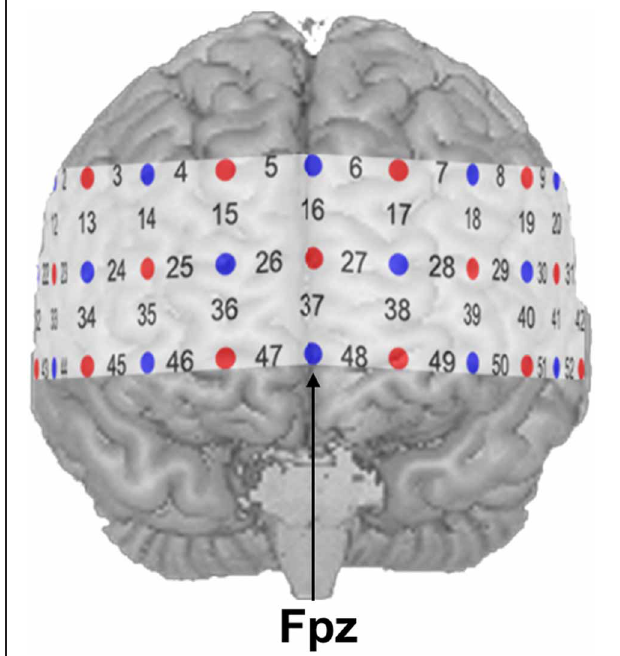
FIGURE 1 | NIRS probe set with 52 channels. Emitters and detectors are represented by red and blue circles, respectively. The detector between channel positions 47 and 48 was placed over Fpz according to the 10–20